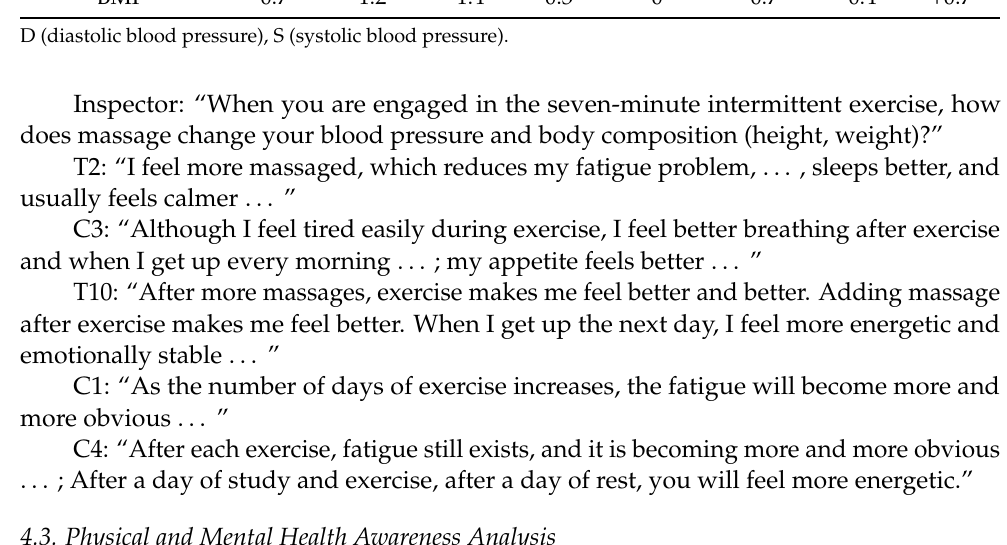
Gender Identity Test-Male/Test- M (Tester/Controller) Female/Control-